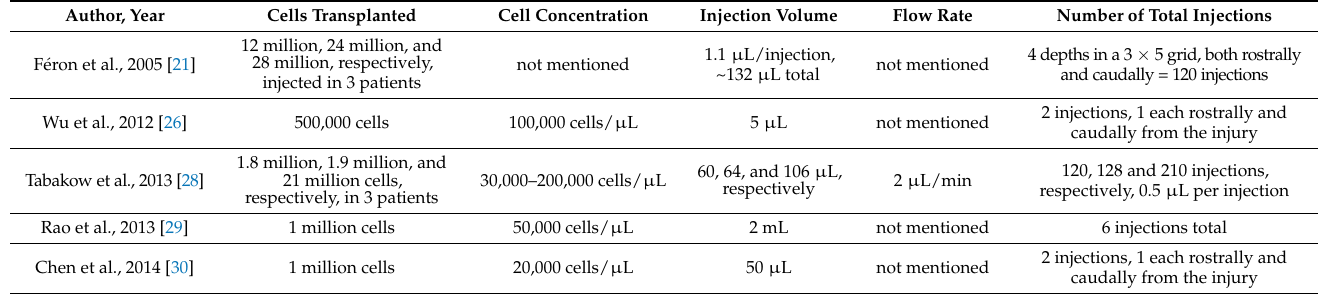
Table 2. Procedural detail summary for cell transplantation in the clinical trials using cell suspension